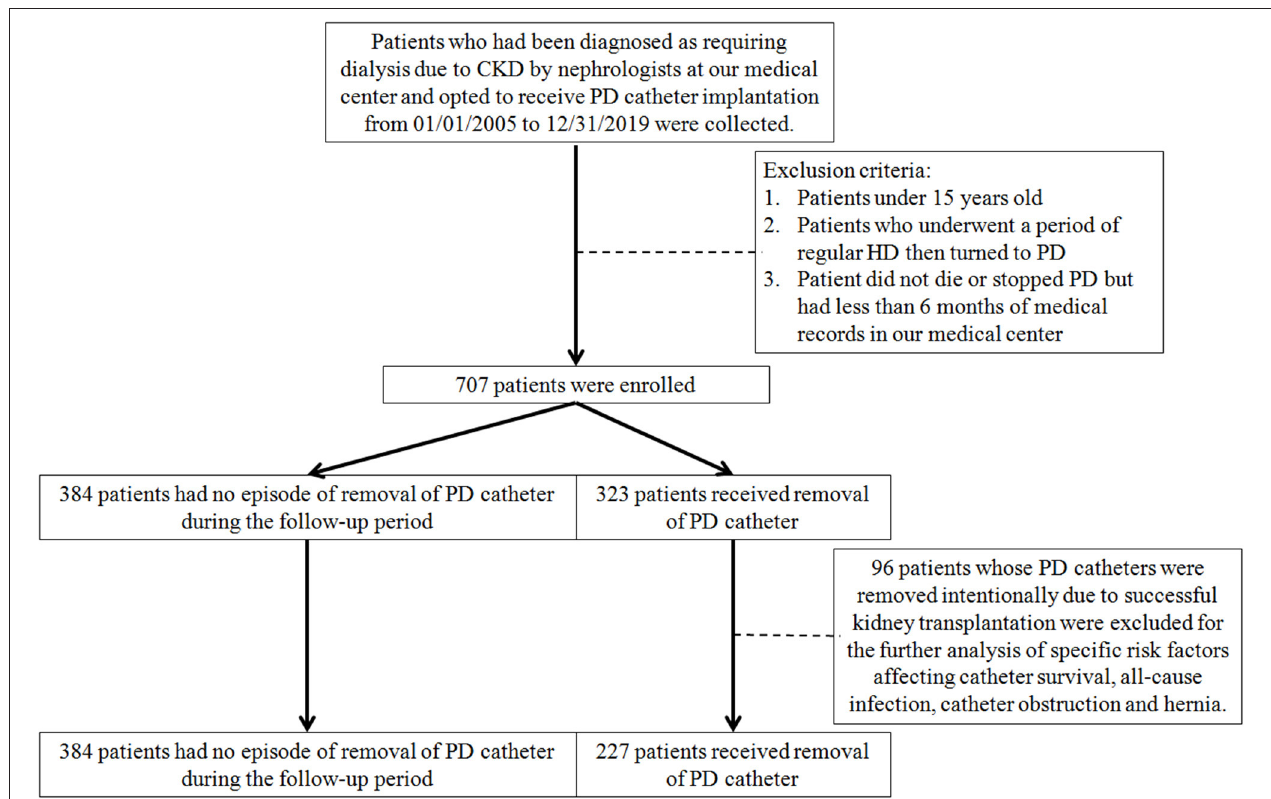
FIGURE 1 | The flowchart for inclusion and exclusion of this study. CKD, chronic kidney disease; HD, hemodialysis; PD, peritoneal dialysis. the HbA1C ≥ 7 group. For patients in the HbA1C < 7 group,